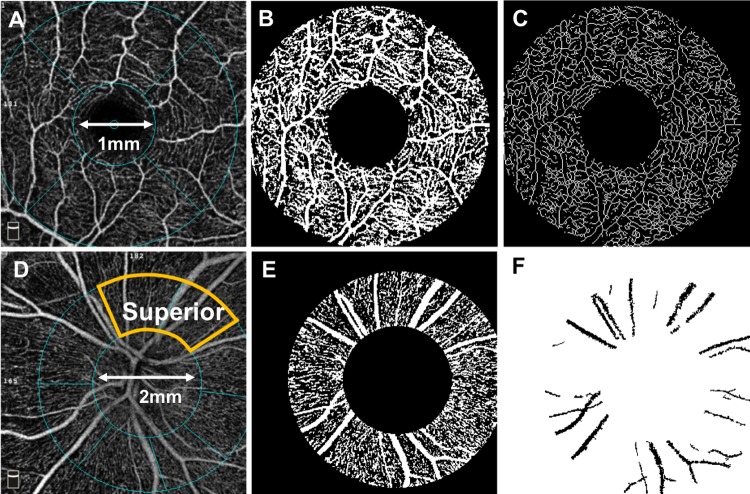
Parafoveal and peripapillary image analysis.A healthy control’s angiograms show the superficial capillary plexus (SCP) of the macula with delineation of the parafovea between rings of 1.0mm and 3.0mm (A), after binarization of parafoveal vessels based on a background defined by the foveal avascular zone (B), and after skeletonizing all vessels to be one pixel wide (C). Bottom row shows the radial papillary capillary (RPC) layer of the same individual with the peripapillary area between rings of 2.0mm and 4.0mm centered on the optic disc and the superior quadrant of the peripapillary delineated in orange (D). Thresholding and binarization with the Phansalkar method in the peripapillary are shown (E). The large vessel masks in RPC (F) was removed from RPC images to obtain the microcapillary vessel density.